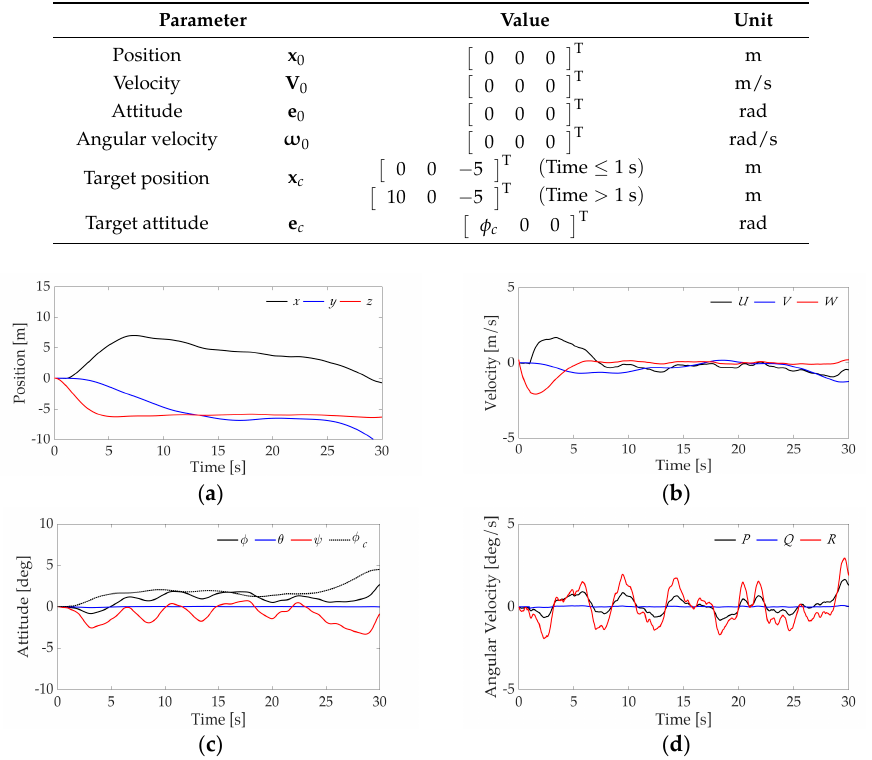
Table 4. Initial condition and target values.